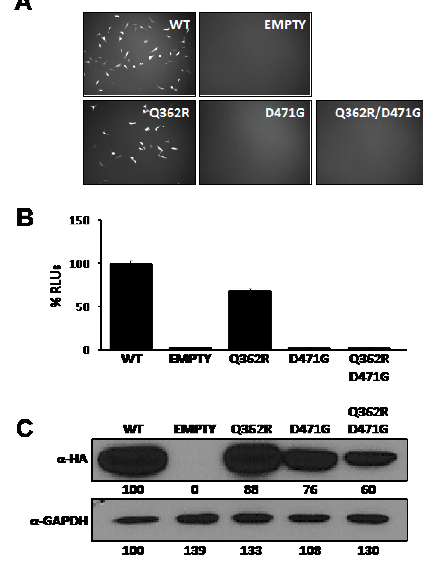
Figure 3. D471G substitution affects the ability of LCMV-NP to promote replication and gene expression of an LCMV MG. BHK-21 cells were co-transfected in triplicate with 0.5 μg of pPolI GFP- Pur/Gluc, together with 0.6 μg of pC - L, 0.3 μg of pC wt or mutant NPs HA- tagged, and 0.1μg of the pSV40 -Cluc expression vector to normalize transfection efficiencies At 48 hpt, MG driven GFP expression (A) and luciferase activity in TCS (B) were determined. Cell lysates were used to determine expression levels of wt and mutant NPs by WB using an anti-HA antibody (C). GAPDH was used as a loading control. Empty pC was used as a negative control. Percentages of relative luciferase units (% RLUs) were normalized with respect to the activity of the wt NP, after normalization of transfection represent the quantification of band intensities normalized to wt NP lane as described in material and